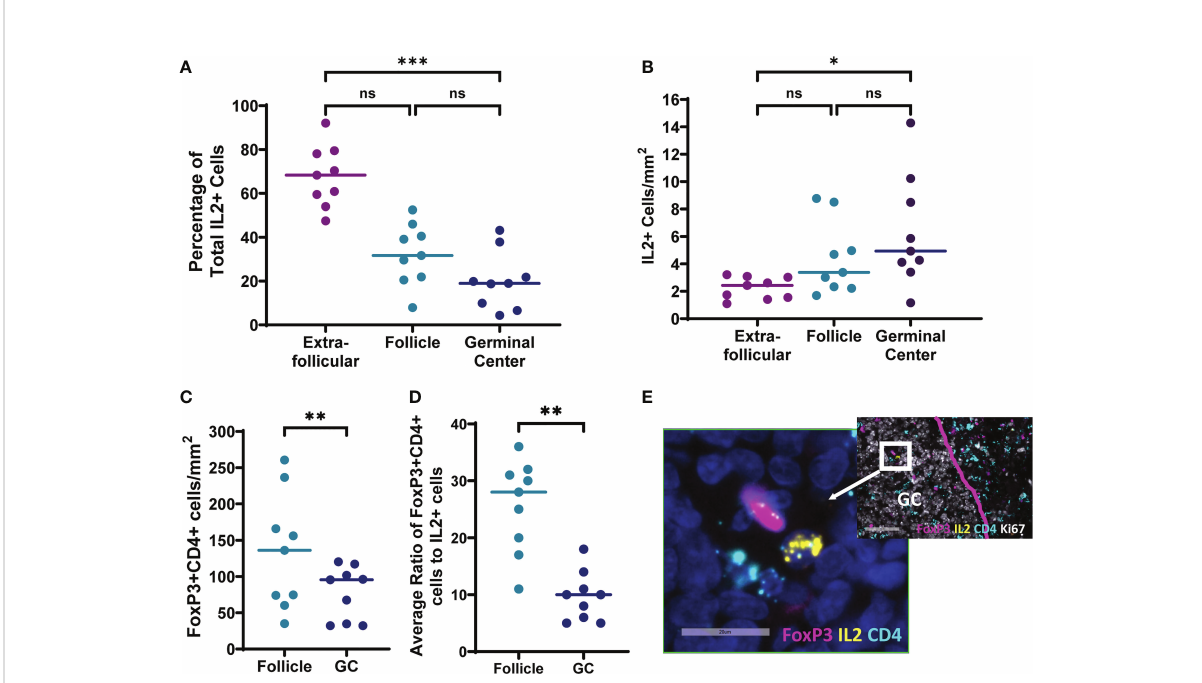
FIGURE 7 IL-2 expressing cells and FoxP3+CD4+ cells are present in follicles and germinal centers of lymph nodes from individuals living with chronic untreated HIV infection. Six micron sections were stained for IL-2 mRNA, CD4 mRNA, FoxP3, DAPI, and either CD20 or Ki67 (n=9). DAPI was used to determine total tissue area. CD20 and Ki67 staining of adjacent sections was used to locate follicles and germinal centers, respectively. Cells were counted manually and frequencies determined by quantitative image analysis. (A) Distribution of IL-2+ cells in extrafollicular, follicular and germinal center regions. Frequencies of (B) IL-2+ cells and (C) FoxP3+CD4+ cells in each region (D) Mean ratios of FoxP3+CD4+ cells to IL-2+ cells were quanti fi ed for each follicle or germinal center containing an IL-2+ cell. (E) Representative image of a cell expressing IL-2 (yellow) adjacent to a cell expressing FoxP3 (magenta) within a germinal center. Both cells, and multiple other surrounding cells are CD4+ (light blue). DAPI staining of nuclei is shown in dark blue. Statistical analyses were performed using nonparametric Friedman tests (A, B) and Wilcoxon tests (C, D) using GraphPad Prism v8 and signi fi cance as indicated: (ns) not signi fi cant p>0.05; *p<0.05; **p<0.01;